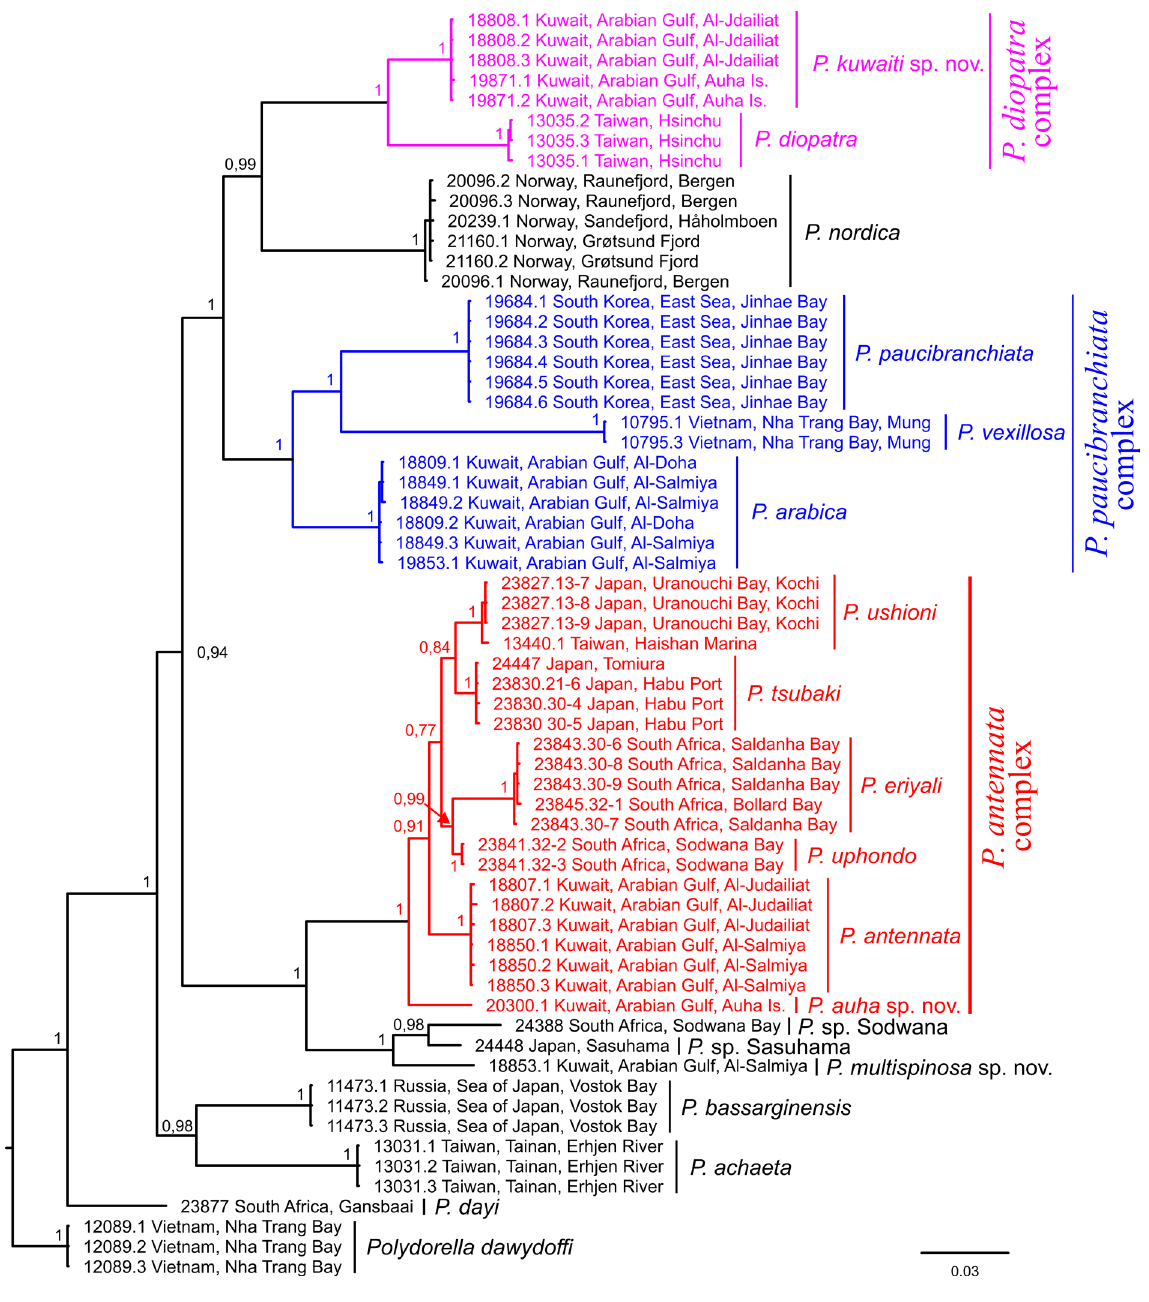
Fig. 2. Majority rule consensus tree of the Bayesian inference analysis of the combined 16S (234 bp), 18S (1639 bp), 28S (294 bp), and Histone 3 (306 bp) sequences (2473 bp in total) of Pseudopolydora spp. rooted with sequences of Polydorella dawydoffi Radashevsky, 1996. Posterior probabilities are shown on the branches. The numbers without letters preceding collecting locations are unique numbers from the VIR database linking the individuals on the tree with the sampling data in Table 1 and Supp. Table ESM1. Pseudopolydora complexes are defined by unique sets of characters shared by the